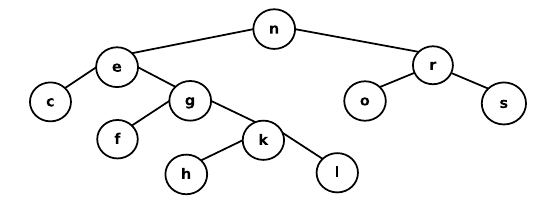
Fig. 1 Sample of a binary search tree corresponding to the set of let- , e , f , g , h , k , l , n , o , r , s } ter { c sorted according to the alphabetic